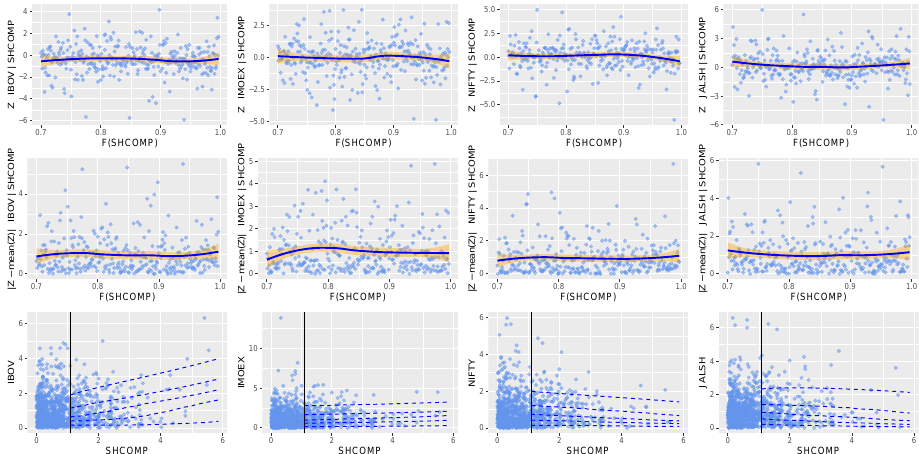
Figure A5. Dependence model diagnostics: conditioning on the SHCOMP